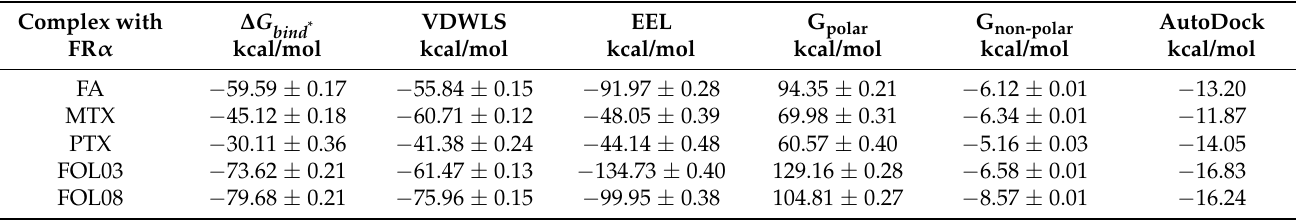
Table 2. Binding free energies from Molecular Mechanics–Poisson-Boltzmann Surface Accessible MM-PBSA for FA, MTX, PTX, FOL03, and FOL08 with FR α from MD simulation trajectories. Molecular docking values from AutoDock for the complexes are also included in the